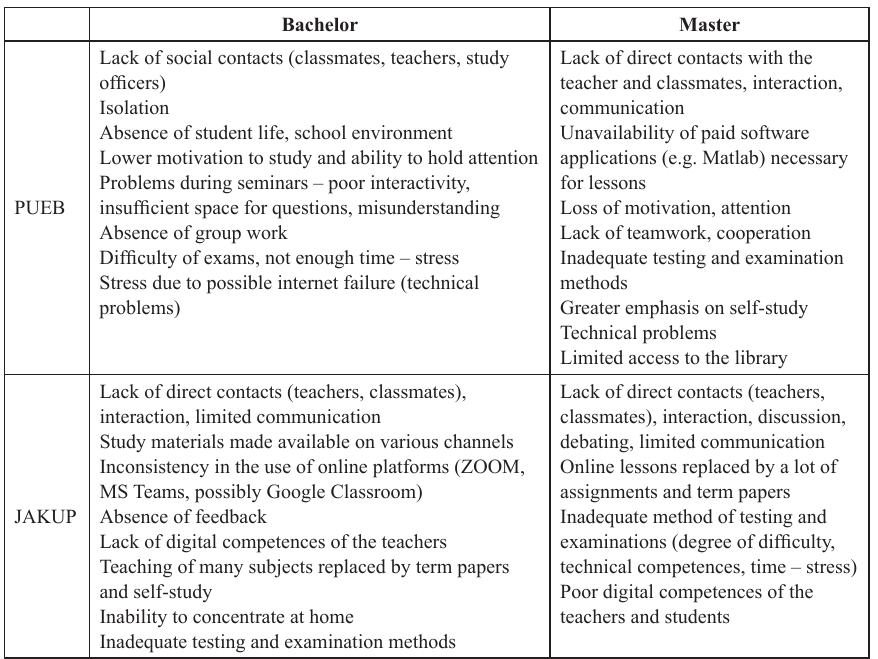
Table 5. From the perspective of students, what are the disadvantages of the